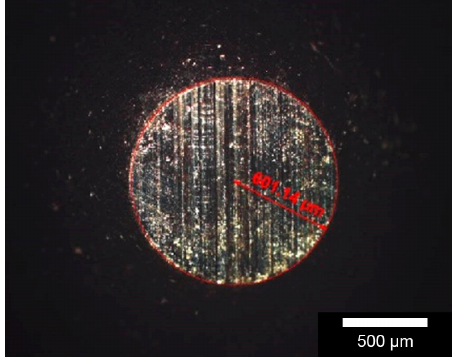
Figure 5. Typical surface wear pattern on a 100Cr6 ball [22]. Resulting tracks of abrasion investigated by a perthometre after the friction ball was sliding oscillative on the polished sample and the volumetric wear was determined.